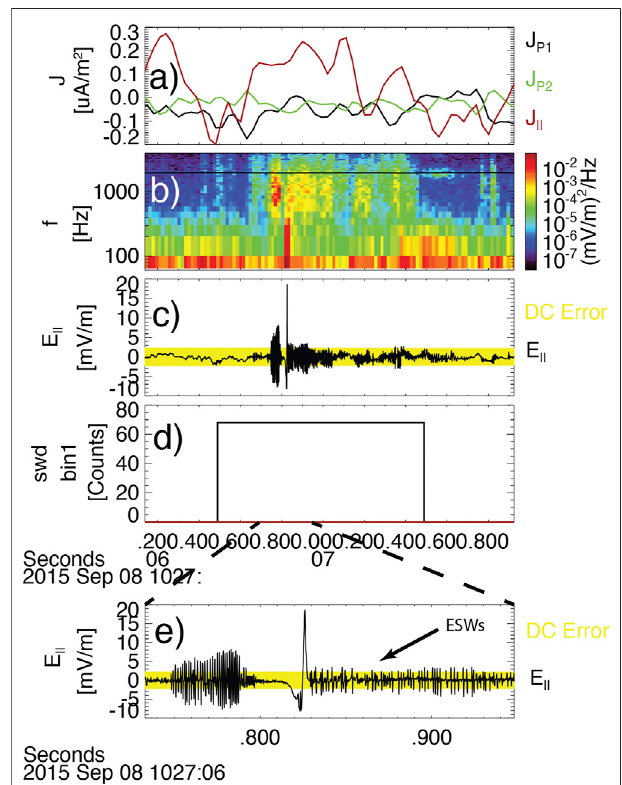
FIGURE3| ZoomonburstdatafortheintervalwithhighestSWDcounts from Figure 2 . (A) electric current density in fi eld-aligned coordinates, (B) electric fi eldpowerspectraldensity, (C) parallelelectric fi eldat8,192Samples/ s, (D) SWD bin1 counts, (E) zoom on the data from (C) to showcase